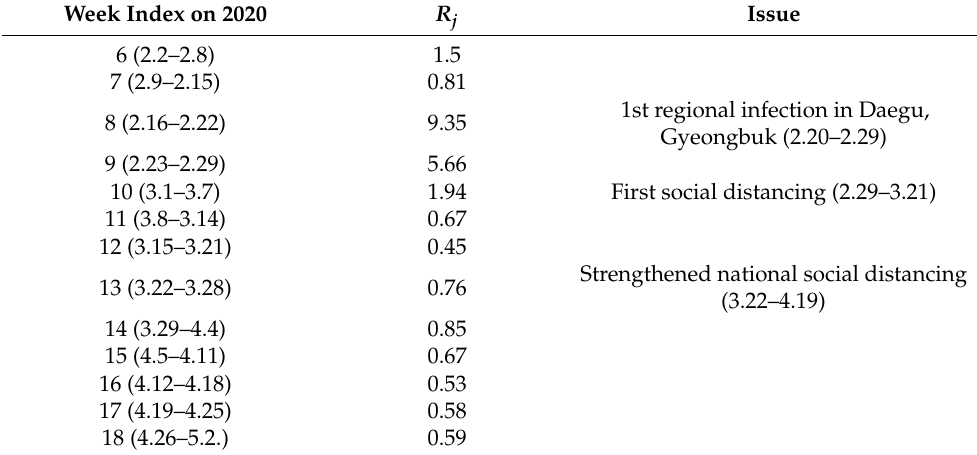
Table 1. Estimated Reproduction Number During the Period March to April 2020 in Korea